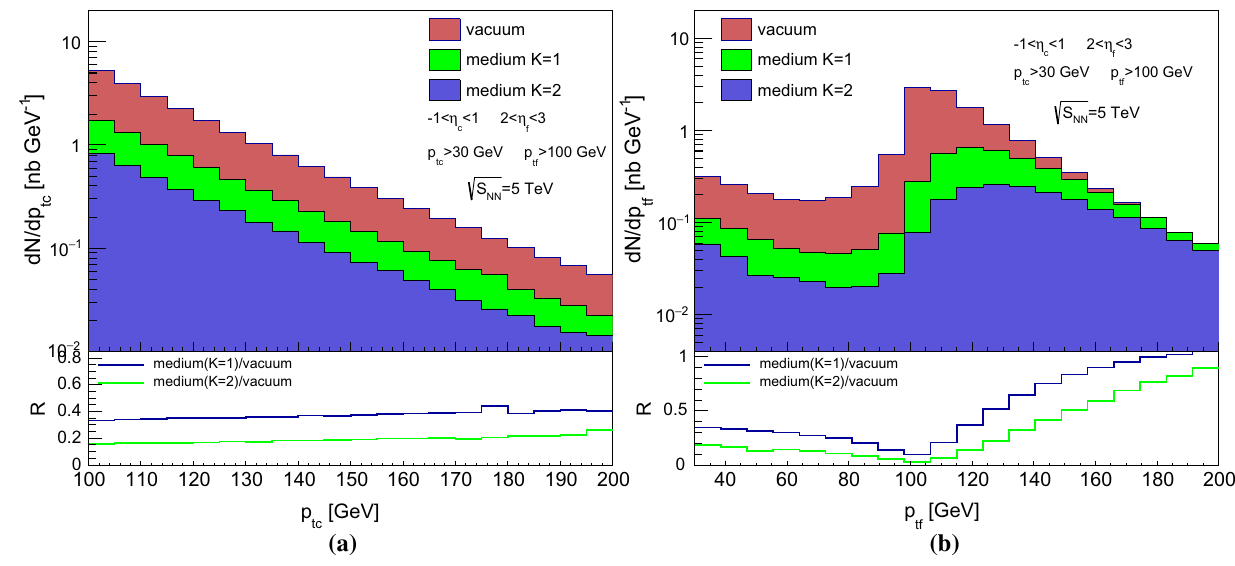
Fig. 3 a Top: Central jet p tc before and after jets pass through the medium. b Top: Forward jet p t f before and after the jets pass through the medium. The red histogram represents the p tc / f of the jet with- out passing the medium. The light green histogram represents the p tc / f